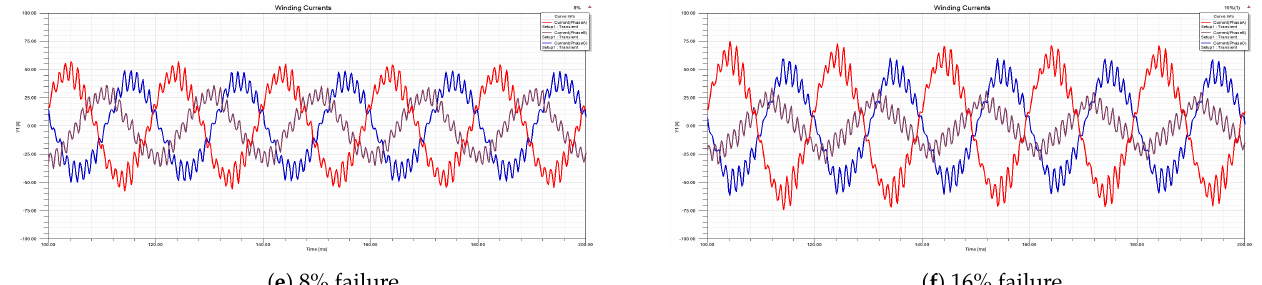
Figure 17. Three phase current curve of the motor under different conditions.